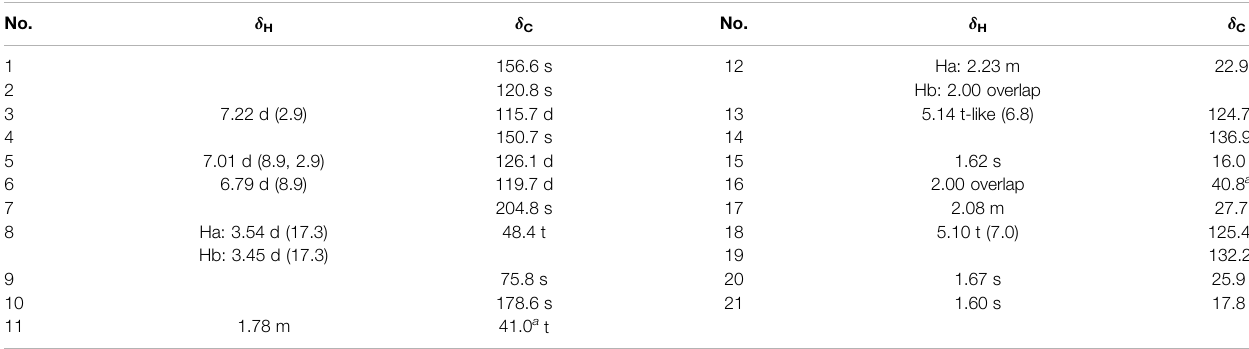
TABLE 3 | 1 H (500 MHz) and 13 C NMR (125 MHz) data of 5 in methanol- d 4 ( δ in ppm, J in Hz).